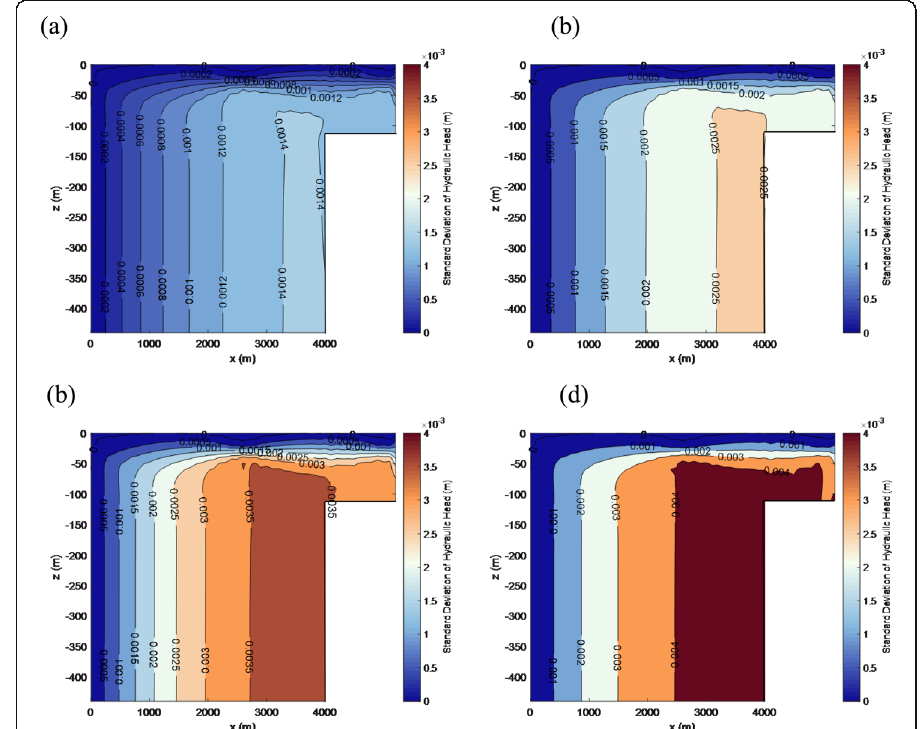
Fig. 7 Effects of the correlation length of E a on the uncertainty of hydraulic head. a l x = 200 m, l z = 40 m. b l x = 400 m, l z = 80 m. c l x = 600 m, l z = 120 m. d l x = 800 m, l z = 160